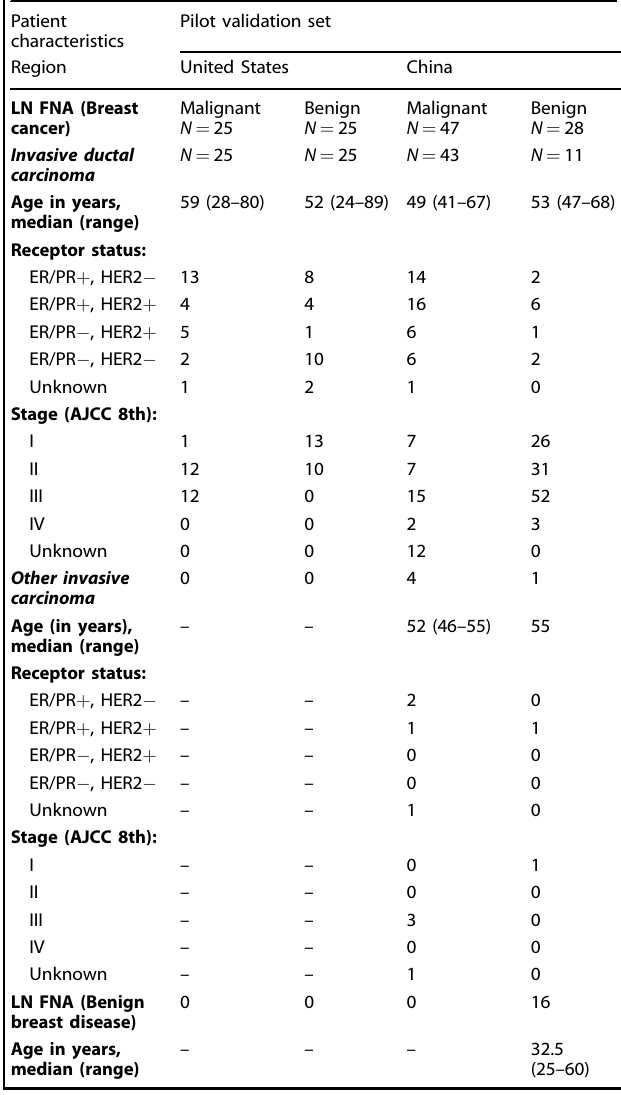
Table 2. Patient characteristics in the pilot clinical validation